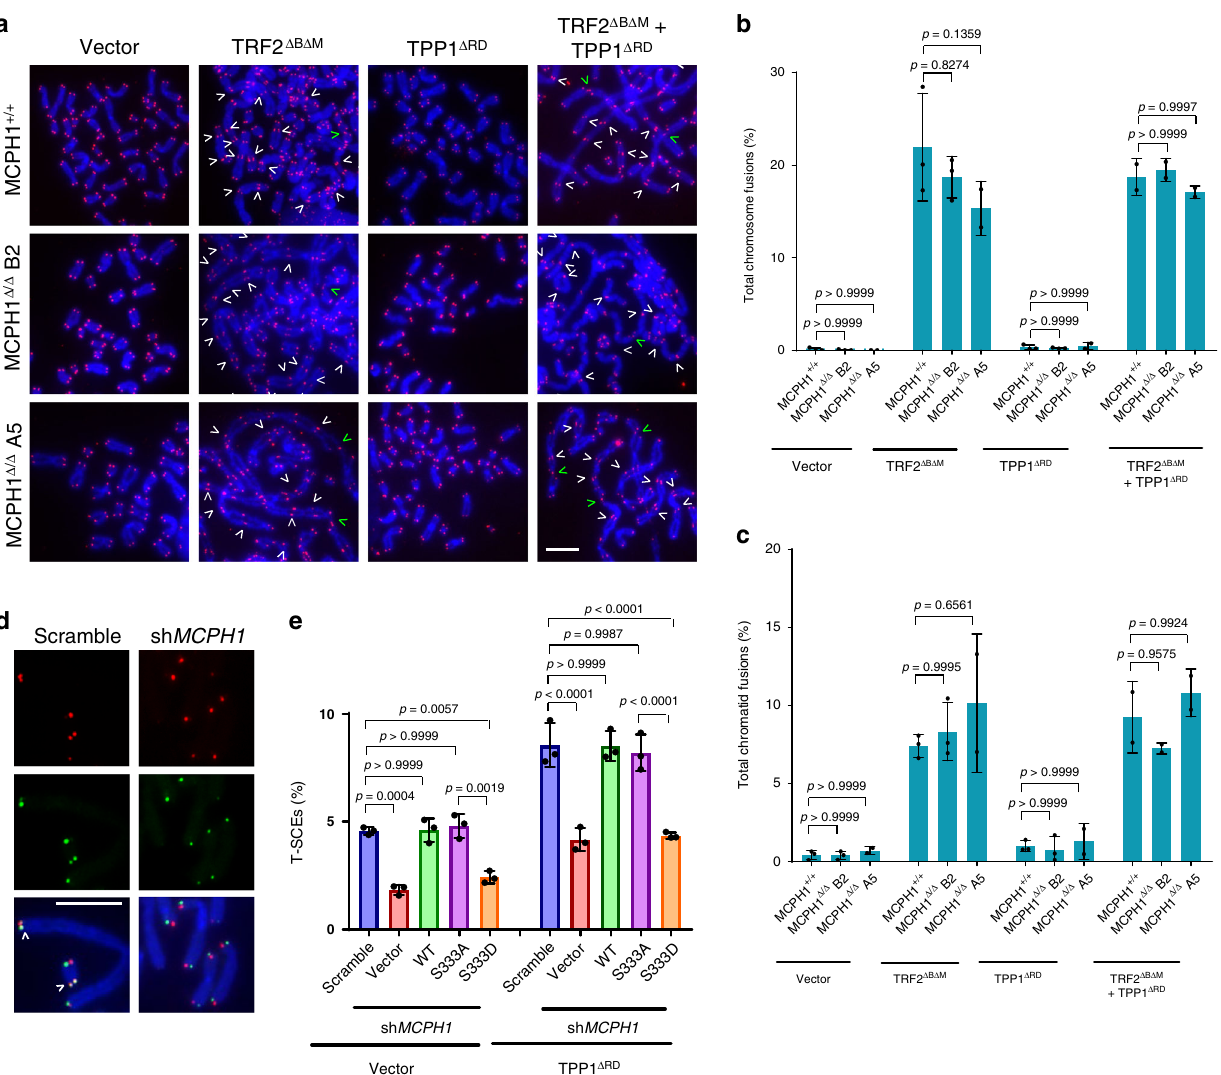
Fig. 4 MCPH1 – TRF2 interaction is required to promote HDR at telomeres lacking POT1-TPP1. a Telomeric PNA-FISH staining of metaphase spreads from MCPH1 + / + , MCPH1 Δ / Δ B2, and MCPH1 Δ / Δ A5 HCT116 cells overexpressing either empty vector, TRF2 Δ B Δ M , TPP1 Δ RD , or both TRF2 Δ B Δ M and TPP1 Δ RD . Telomeres were detected using a PNA probe (red) and DAPI was used to stain the chromosomes (blue). Representative images from either three (MCPH1 + / + and MCPH1 Δ / Δ B2 + vector, TRF2 Δ B Δ M , or TPP1 Δ RD ) or two (MCPH1 Δ / Δ A5 and samples with TRF2 Δ B Δ M + TPP1 Δ RD )